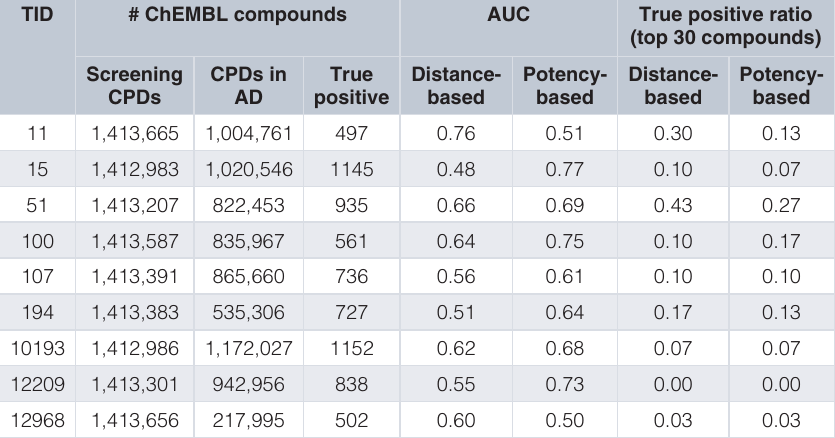
Table 6. Virtual screening details. Compound (CPD) statistics and VS results for distance- based compound rankings relative to optimized coordinates and potency-based rankings are reported.